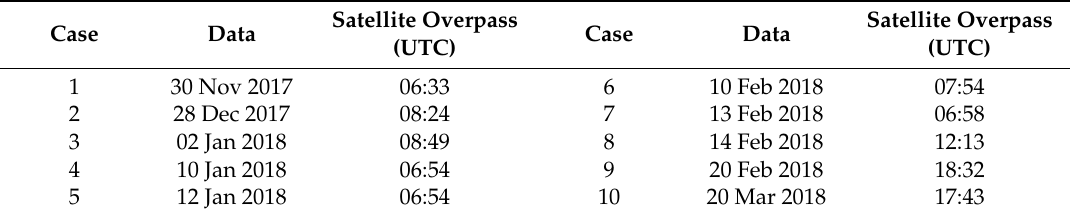
Table 1. List of case studies.